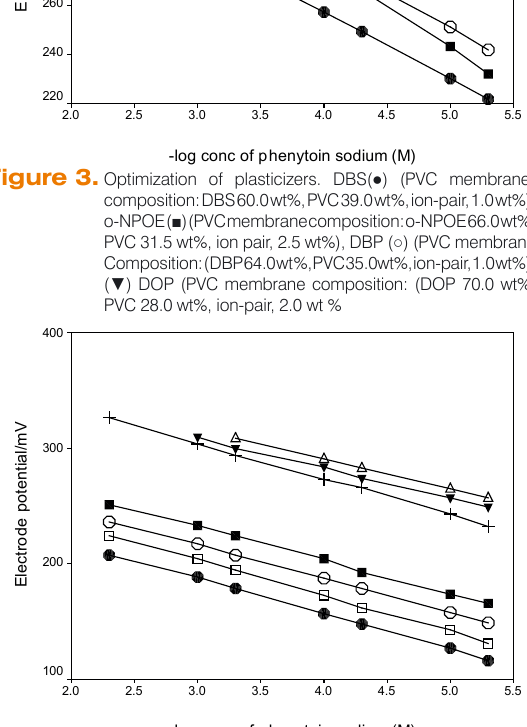
Figure 4. Calibration graphs obtained at 25±1ºC after soaking the phenytoin-tungstosilicate-PVC membrane electrode for ( ● ) 9 h, (  ) 24 h, ( ○ ) 7 days,( ■ ) 12 days, (+) 18 days, ( ▼ ) 25 days, ( ∆ ) 30